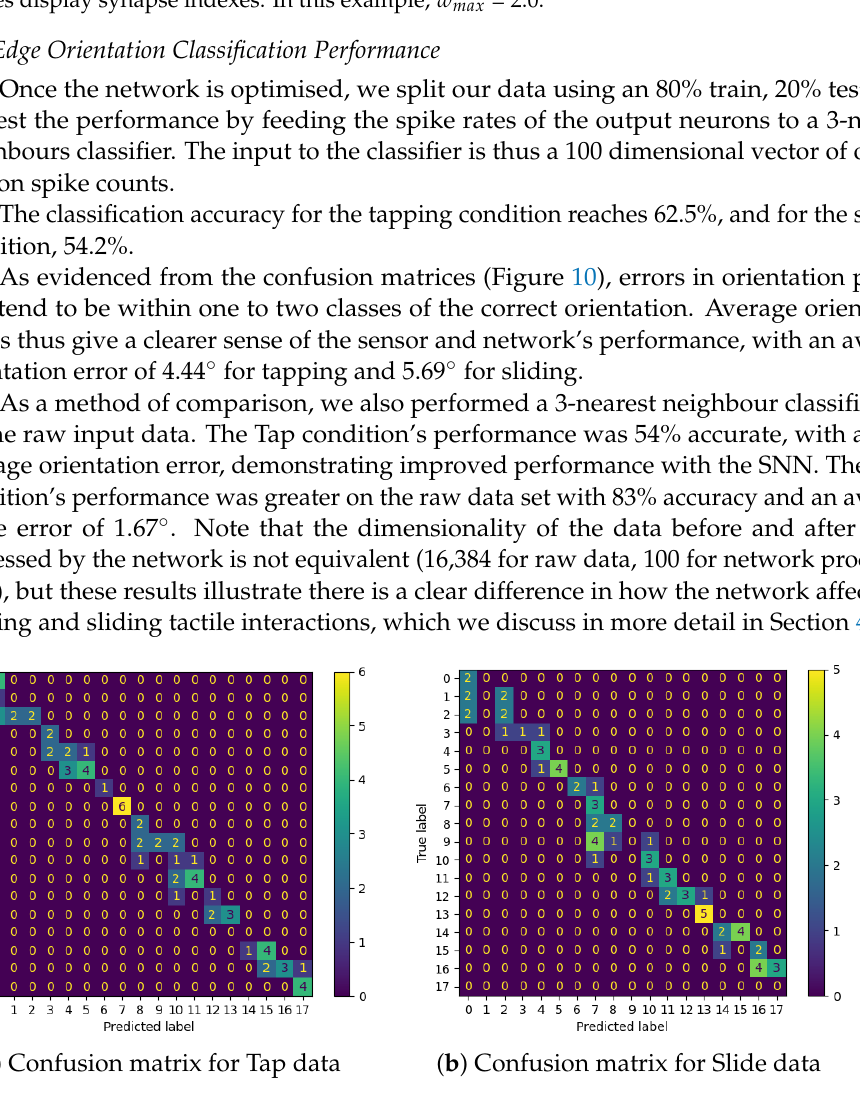
Figure 10. Confusion matrices for edge orientation classification performance with Tap ( a ) and Slide ( b ) over the range of edge orientations (0–170 ◦ in steps of 10 ◦